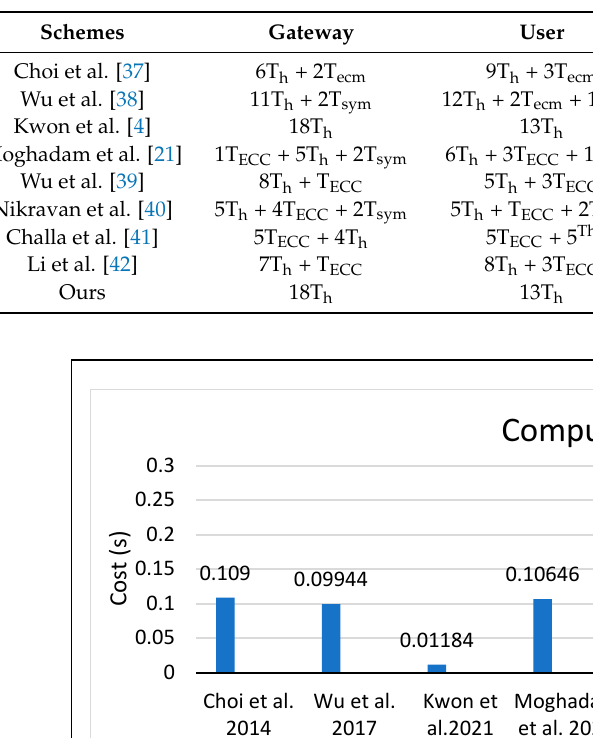
Table 11. Comparison of the login and authentication computational costs.